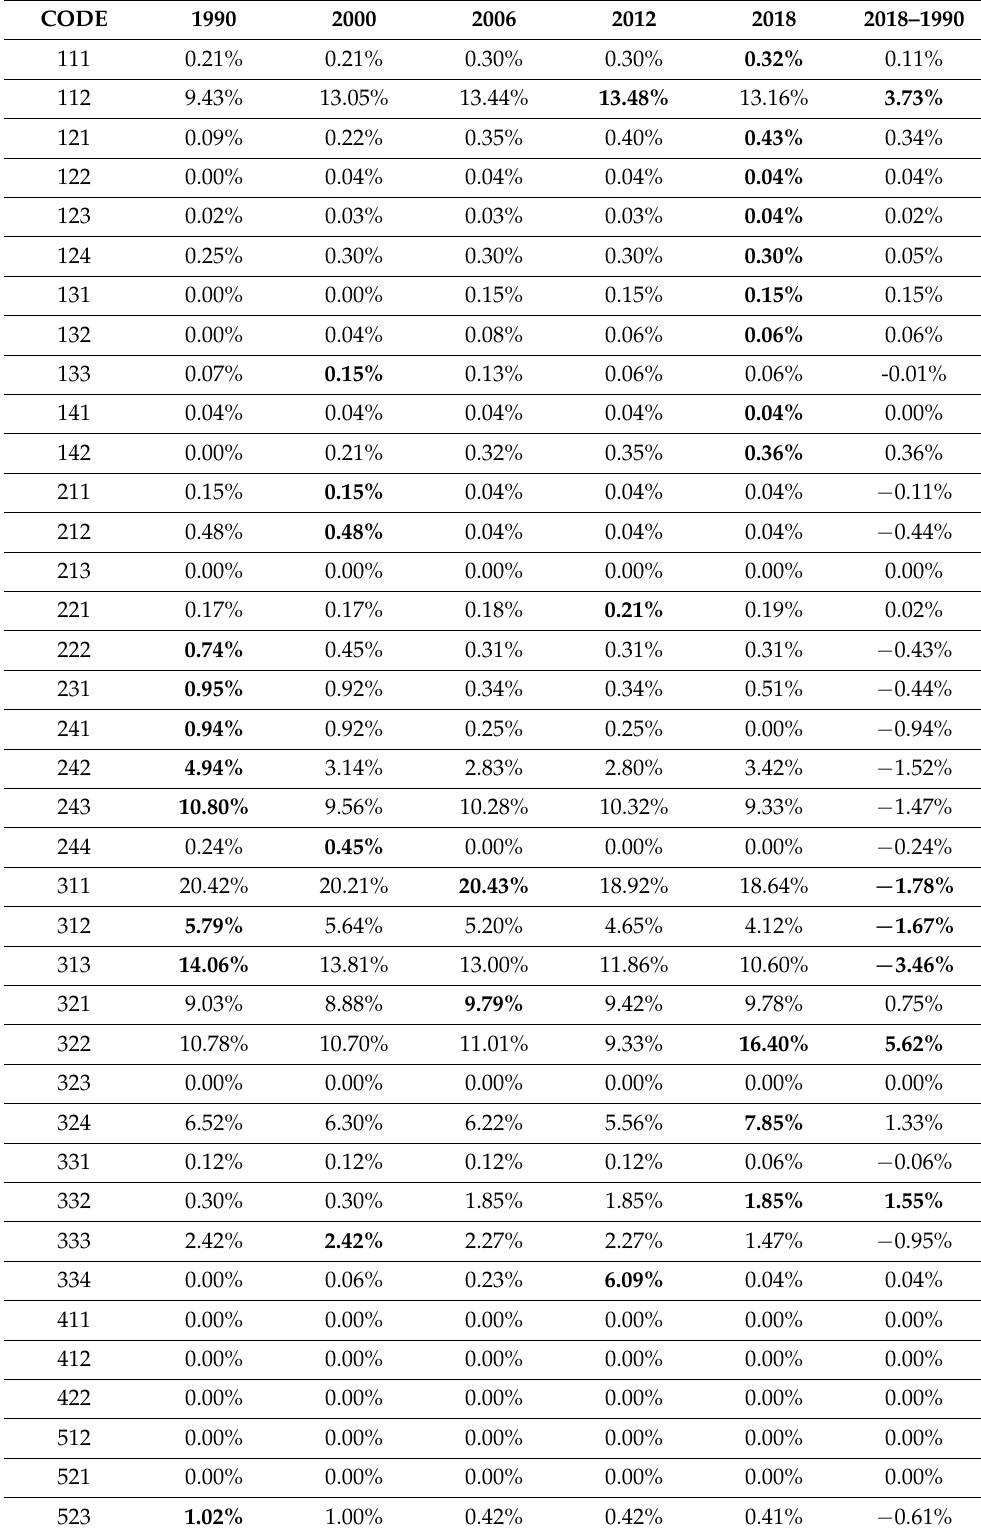
Table 5. Percentage of land-uses according to CLC nomenclature in the Autonomous Region of